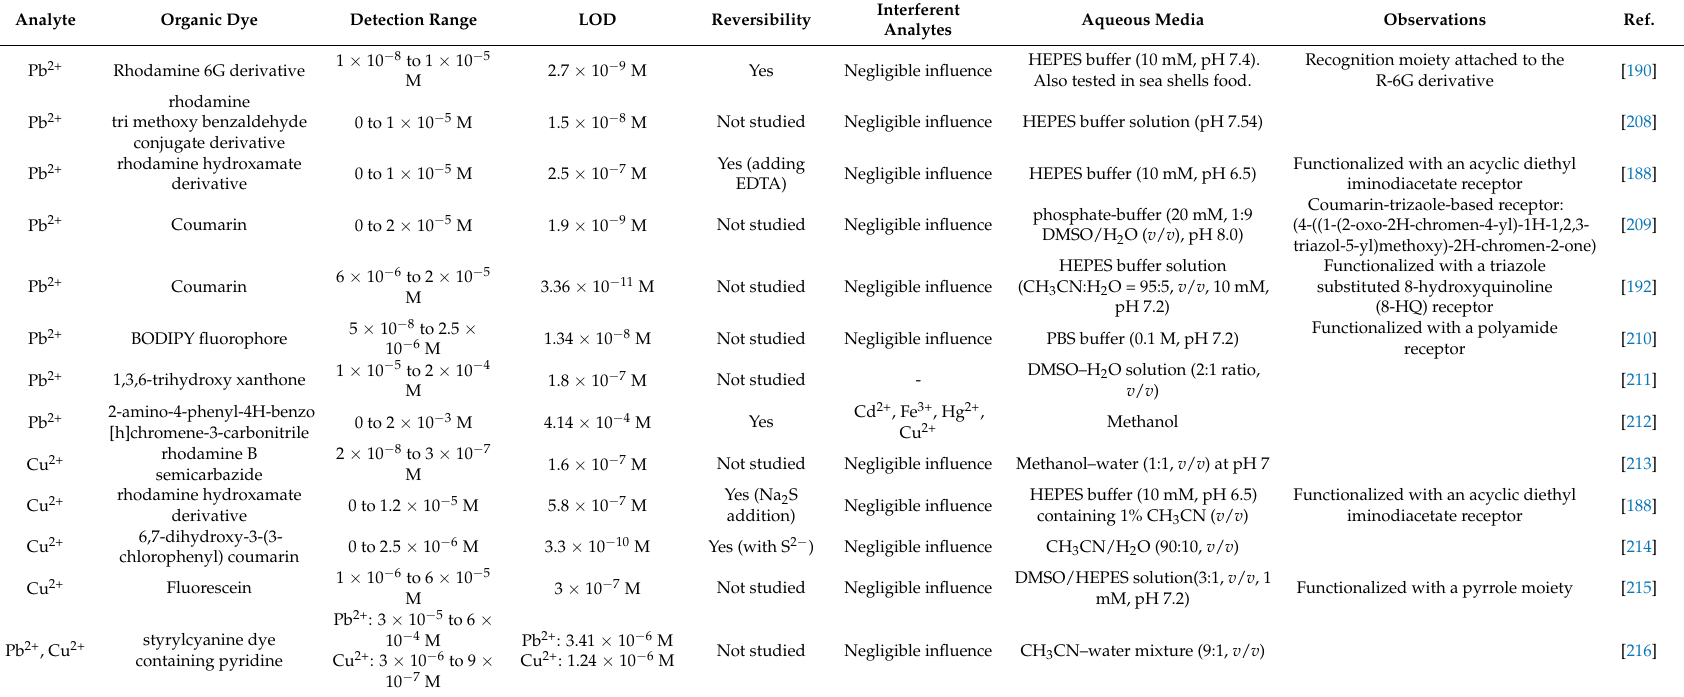
Table 6. Fluorescent sensors for different metal ions based on organic